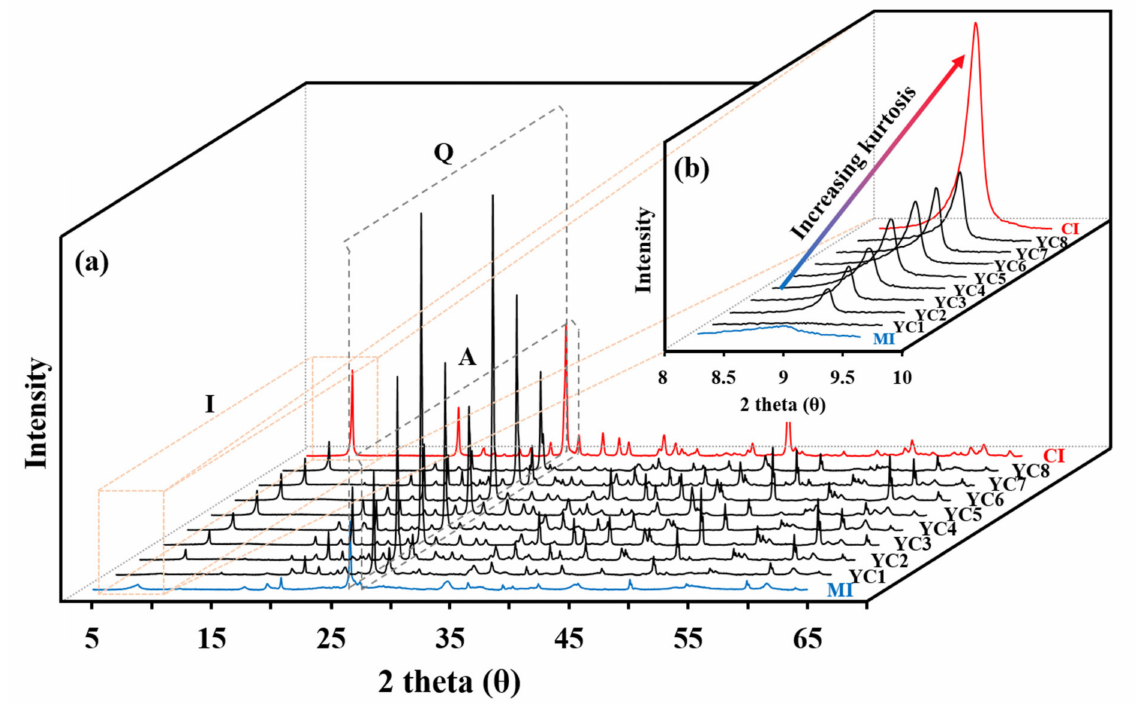
Figure 1. ( a ) XRD peaks and ( b ) enlarged 10Å peak of illite for MI, CI, and YC1–8 (I: illite, Q: quartz, A: